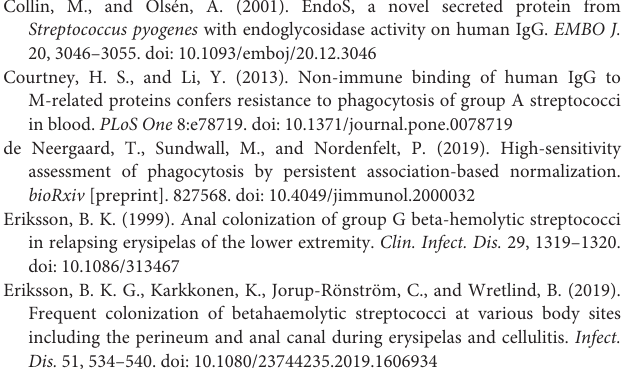
Supplementary Figure 1 | Phagocytosis of S . dysgalactiae isolated from the patient with three bacteraemia episodes with seroconversion. The bacteria were opsonised with the acute serum from episode 2 (black, as2), 3 (pink, as3), or the convalescent serum (green, cs3) and then incubated with the THP-1 cells. Data was acquired through flow cytometry and is presented as mean ± SD, n = 4. The average number of prey associated (A) 14.4 ± 3.1, 10.8 ± 3.7, and 11.0 ± 2.2 SD (both adhered and internalised) and internalised (B) 7.5 ± 1.6, 6.4 ± 1.5, and 7.0 ± 0.8 per internalising phagocyte at MOP 50 (as2, as3, and